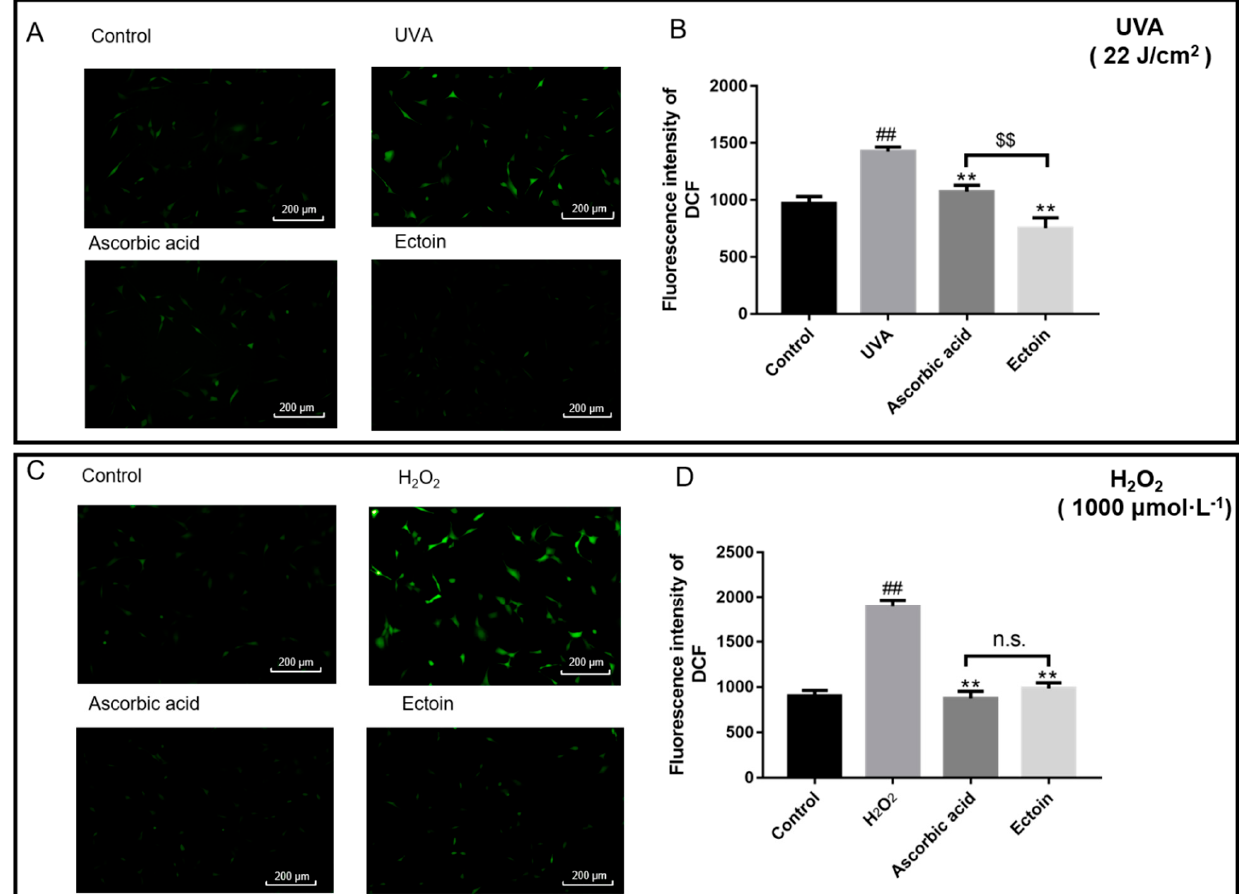
Figure 4. ( A , B ) Effects of Ectoin and ascorbic acid on ROS production induced by UVA/H 2 O 2 stimulation; ( C , D ) effects of Ectoin and ascorbic acid on ROS content in HSF cells stimulated by UVA/H 2 O 2 . Statistical significance was determined by ANOVA test. (## p < 0.01, compared with the Control. ** p < 0.01, compared with the Model. n.s., p > 0.05).